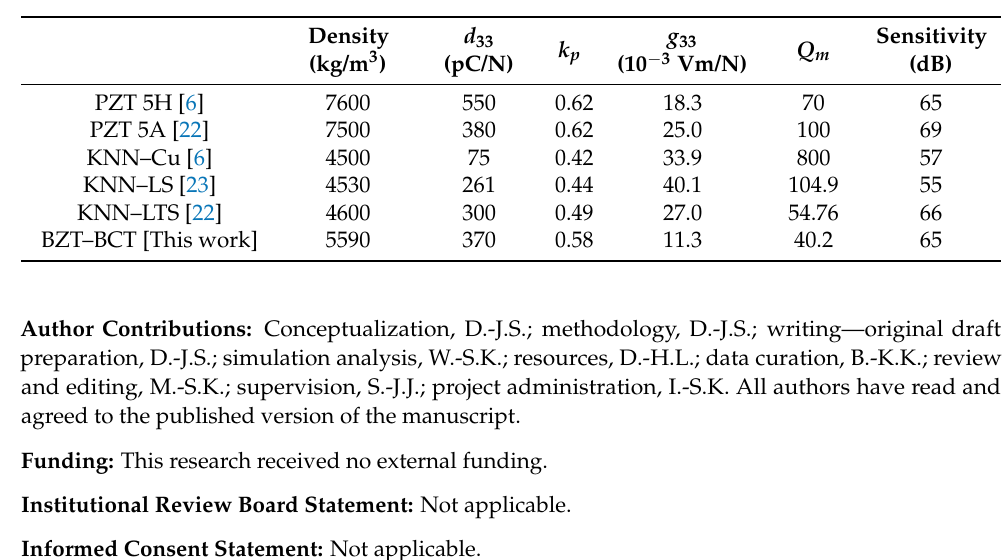
Table 2. Piezoelectric and AE sensor characteristics of piezoelectric ceramics for AE